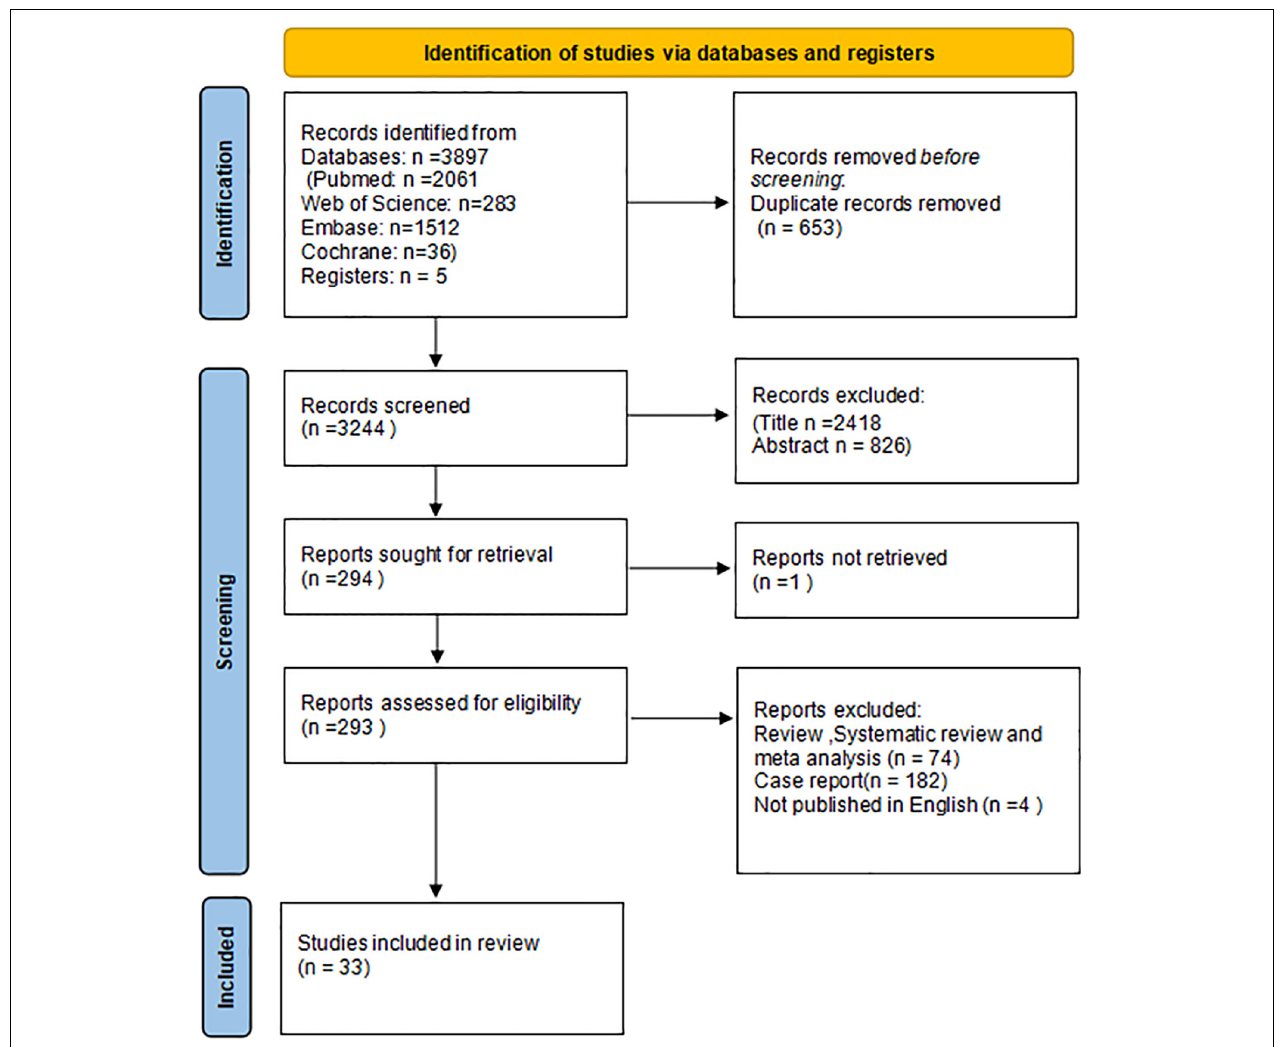
FIGURE 1 | Preferred reporting items for systematic reviews and meta-analyses (PRISMA) flow